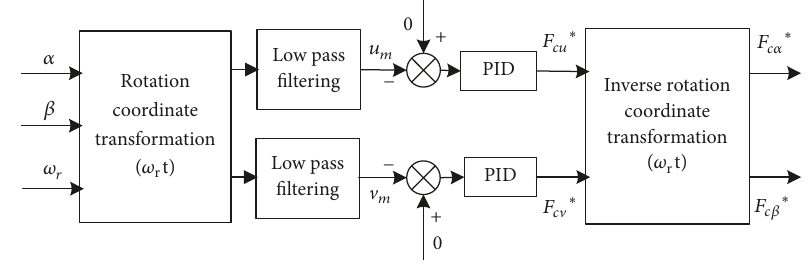
Figure 3: Unbalance vibration compensation controller.